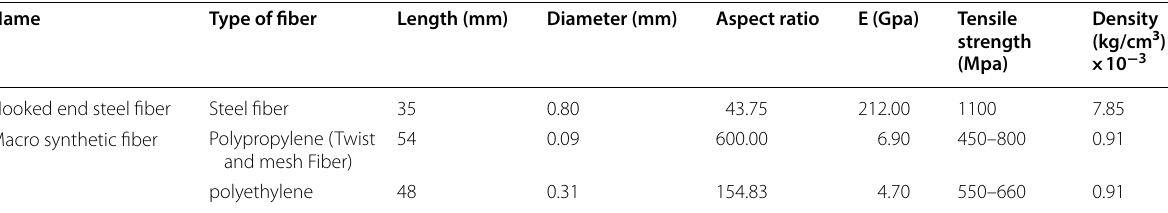
Table 2 Main properties of fiber used in this study.